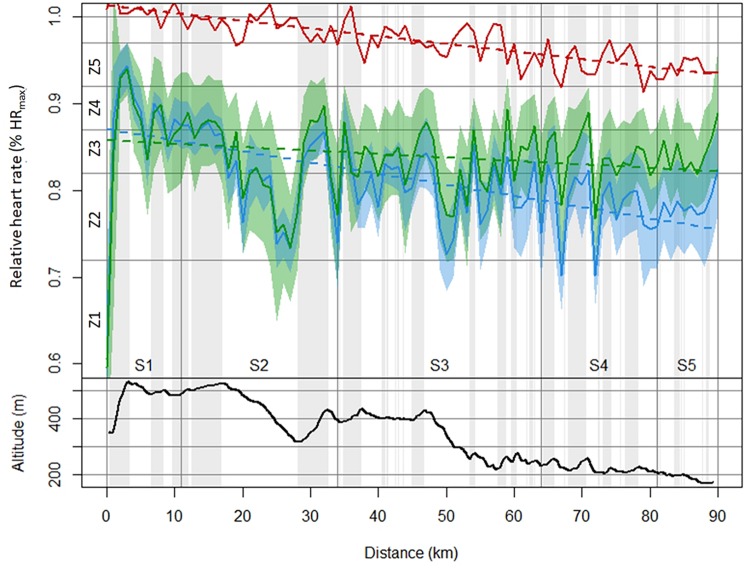
Relative exercise intensity of elite (green) and amateur level (blue) skiers across the 90-km Vasaloppet race. The black line represents the altitude profile with gray-shaded areas illustrating uphill sections; the red line represents the difference in the mean exercise intensity between the groups, with the scattered red line representing the linear regression.